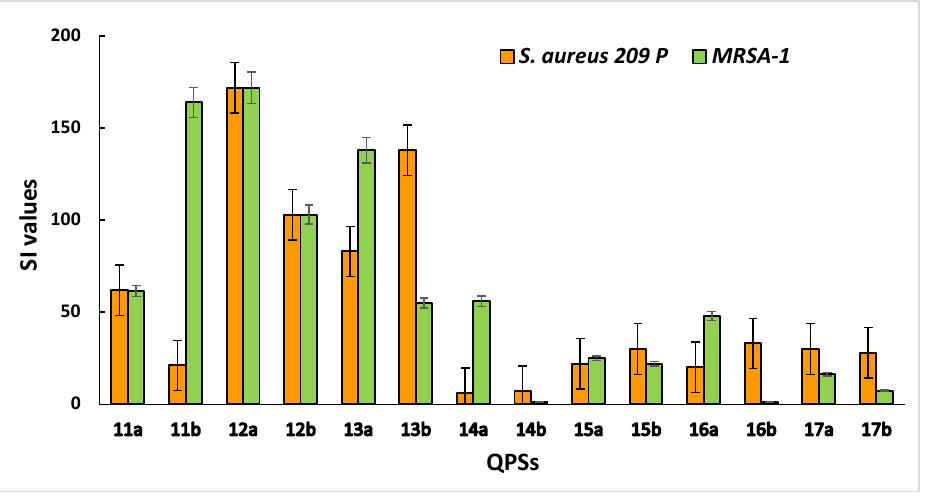
Figure 2. Selectivity of QPSs for bacteria ( S. aureus 209 P and MRSA-1 ) compared to red blood cells.